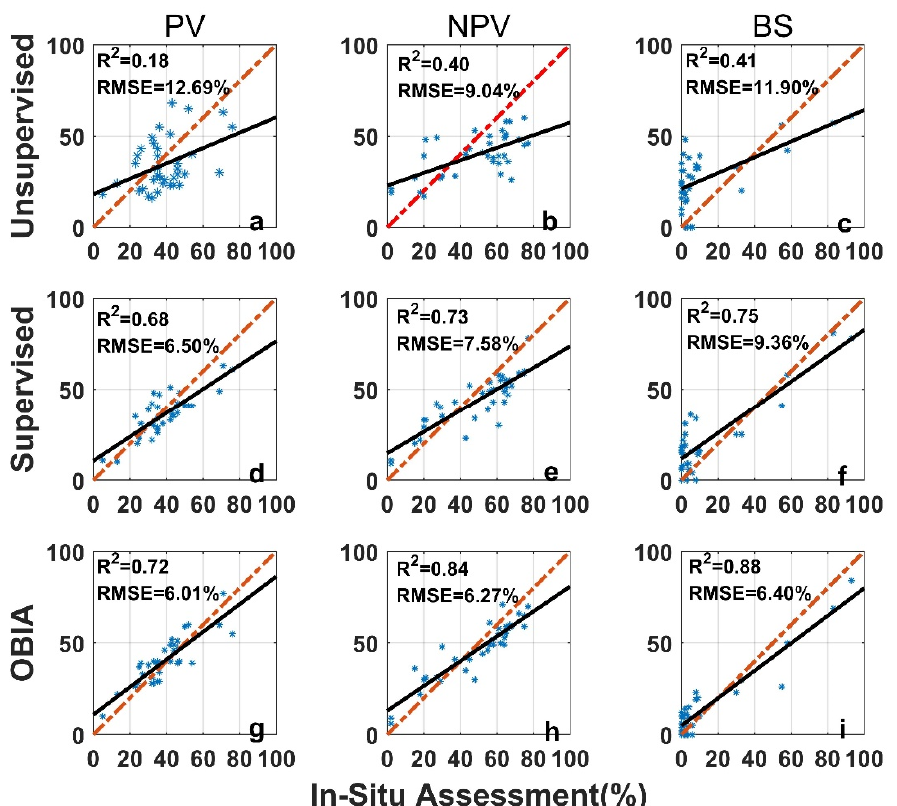
Figure 7. Comparison of in situ assessment and three image analysis methods (unsupervised ( a – c ), su-pervised ( d – f ), and OBIA ( g – i )) for PV ( a , d , g ), NPV ( b , e , h ), and BS ( c , f , i ) fraction covers (the red dashed line is the 1:1 relationship and the dark solid line is the linear regression). The re-gression significance level ( p -value) is 0.01.